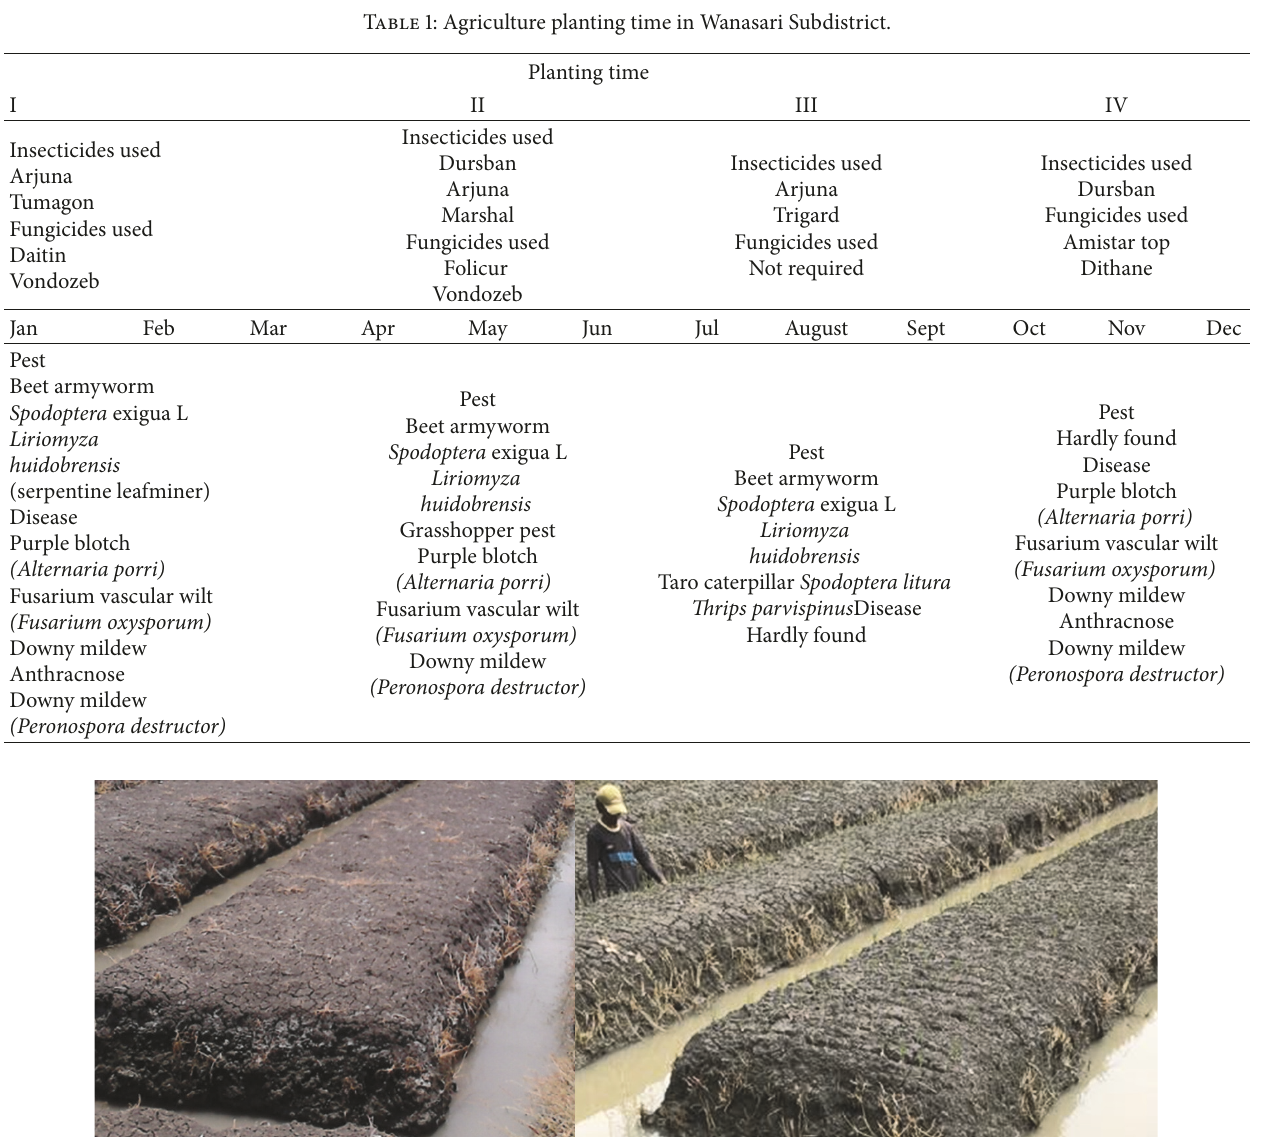
Figure 2: Hard soil texture and brown-white color soil, taken from agriculture area in Wanasari. Source: researcher